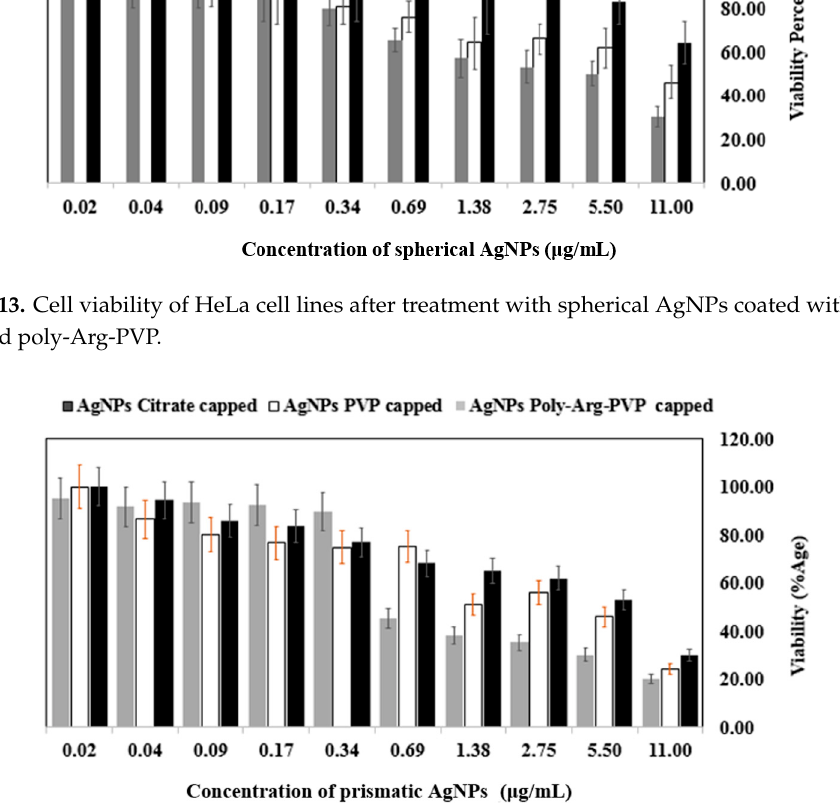
Figure 14. Cell viability of HeLa cell lines after treatment with prismatic AgNPs coated with citrate, PVP and poly-Arg-PVP.